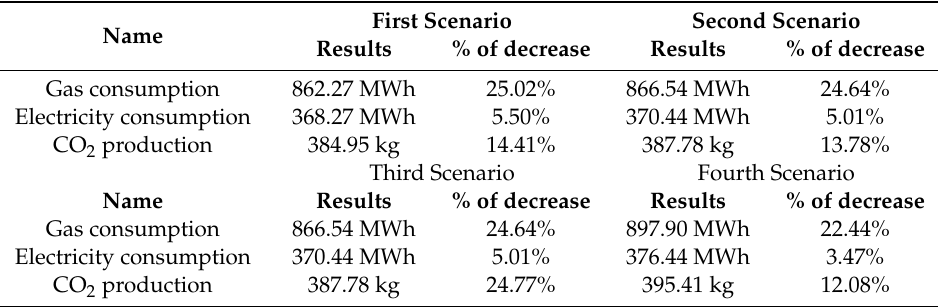
Table 8. Results of the simulation of the first